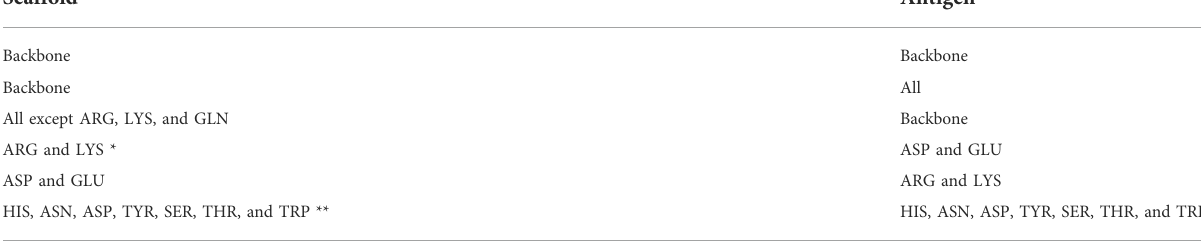
TABLE 2 Amino acid types allowed to form H-bonds in the MutDock approach.